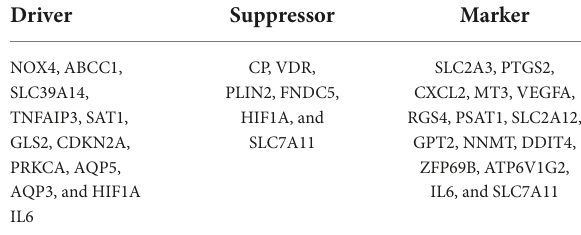
TABLE 2 The ferroptosis differentially expressed genes (DEGs) were divided into ferroptosis driver, suppressor, and